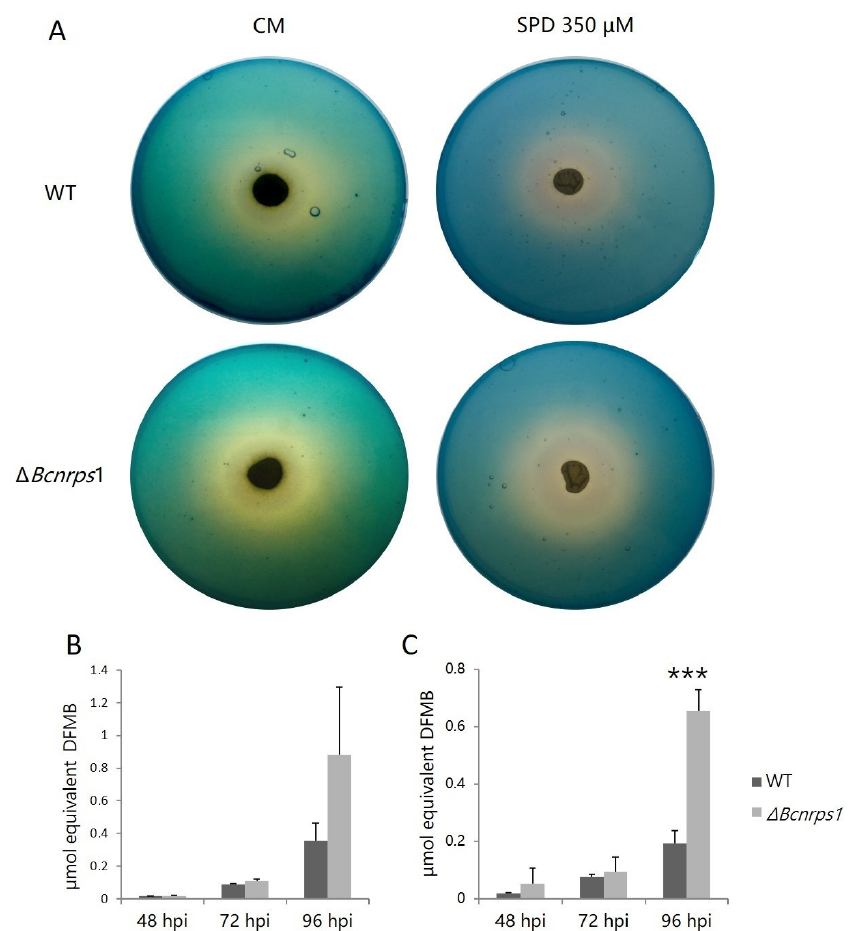
Figure 6. ( A ) Siderophores excretion assay on plates with CAS blue agar with B. cinerea B05.10 (WT) and Δ Bcnrps 1 strains cultivated on complete medium (CM) and CM supplemented with 350 µ M SPD for 96 h at 25 °C under darkness. Equiva- lent of siderophore standard DFMB excreted by B. cinerea WT (gray) and the Δ Bcnrps 1 strain (light gray) cultivated on ( B ) CM medium and ( C ) CM medium supplemented with SPD 350 µ M at 25 °C under darkness. Error bars represent standard deviation of means ( n = 3). Asterisks indicate significant differences between WT and Δ Bcnrps 1 strains in each condition, according to two-way ANOVA, post hoc Tukey’s HSD test for factors strain and hours post inoculation (hpi) ( p -value < 0.001,